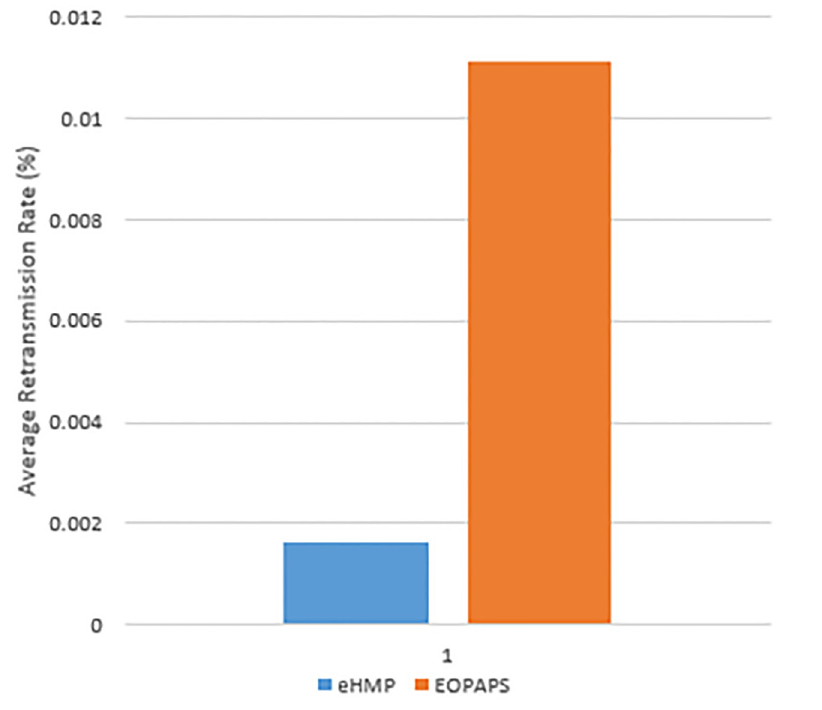
Fig 23. The retransmission rate using eHMP and